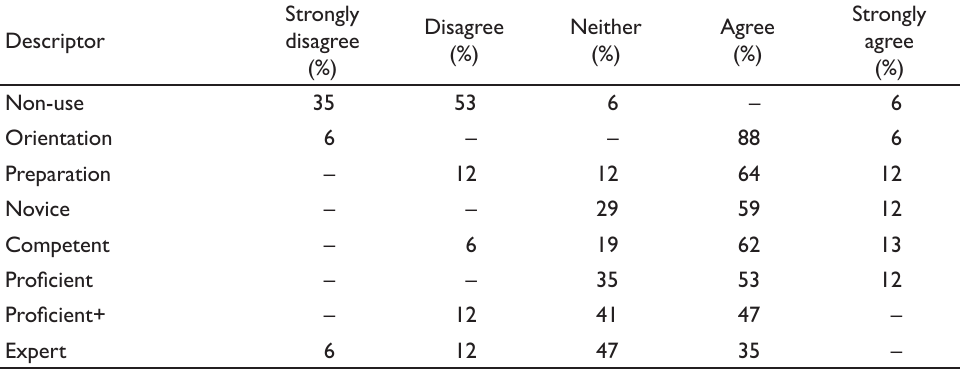
Table 2: Findings by typology, derived from the combined expertise and Levels of Use scale (n=34)